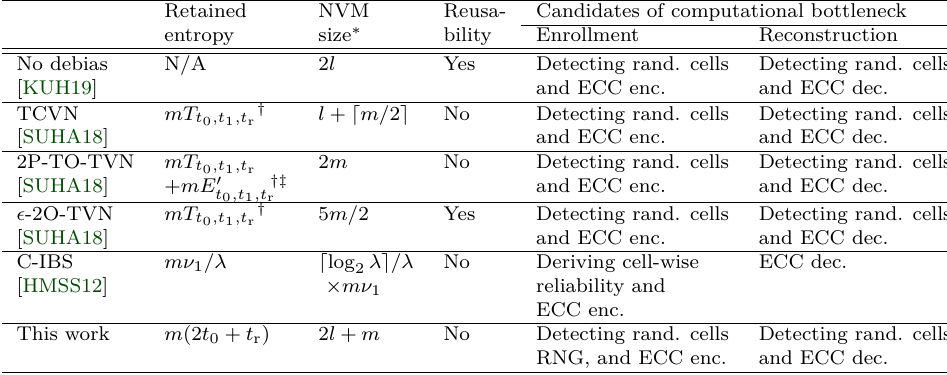
[HMSS12] reliability and